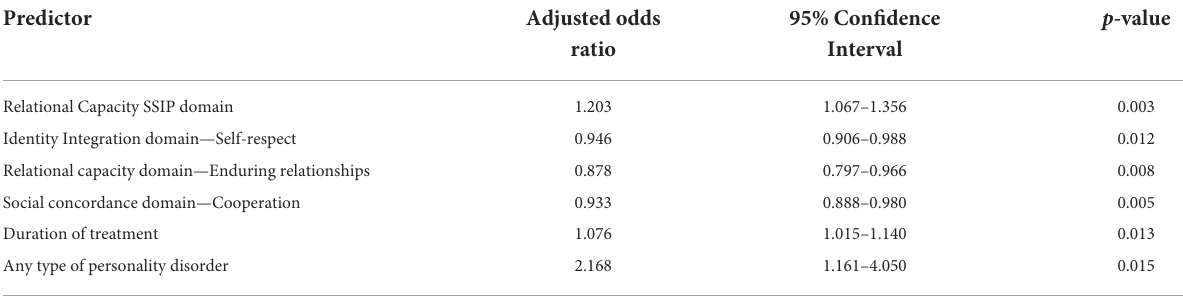
TABLE 3 Potential predictors of HCV